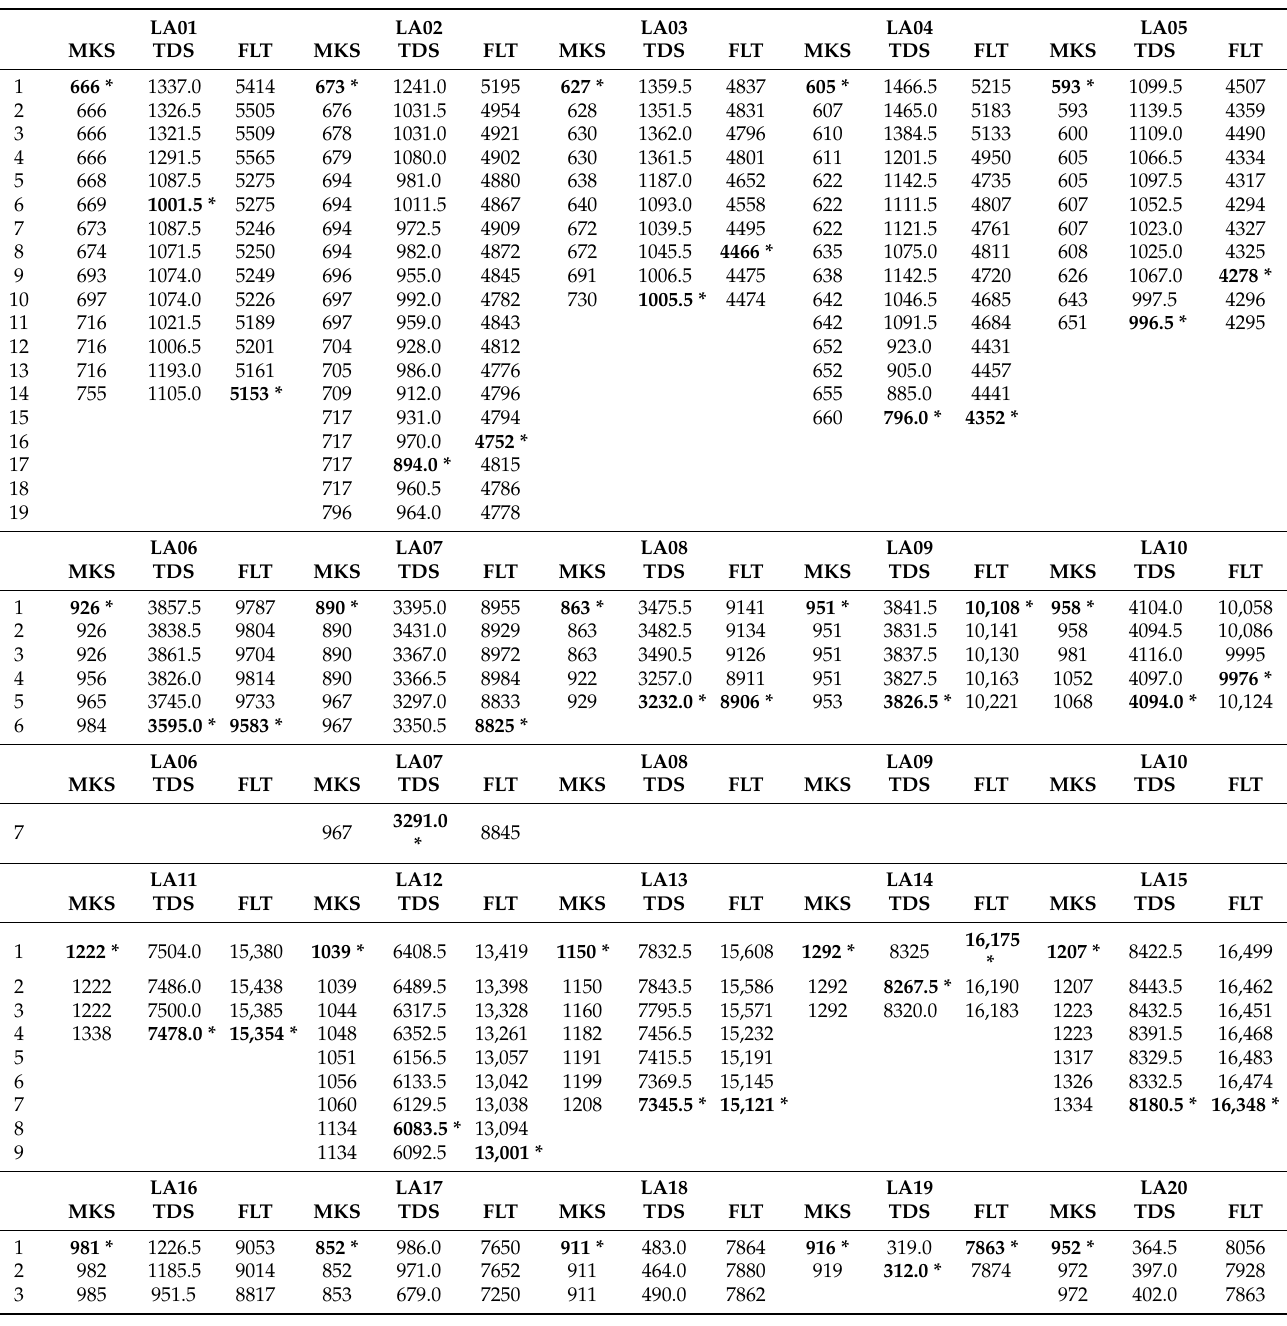
Table A3. Non-dominated solutions obtained by SS/LS for the JSSP instances proposed by